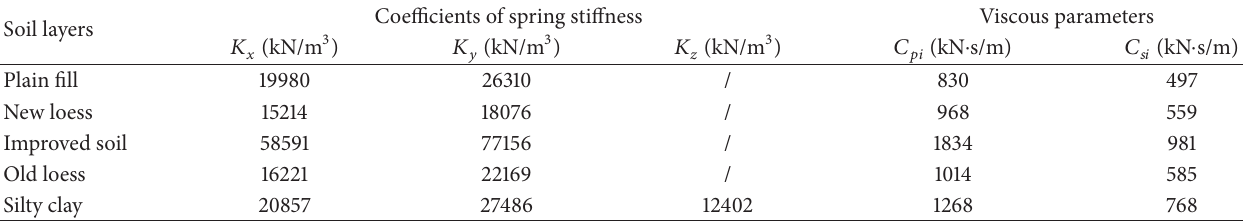
Table 2: Boundary parameters.